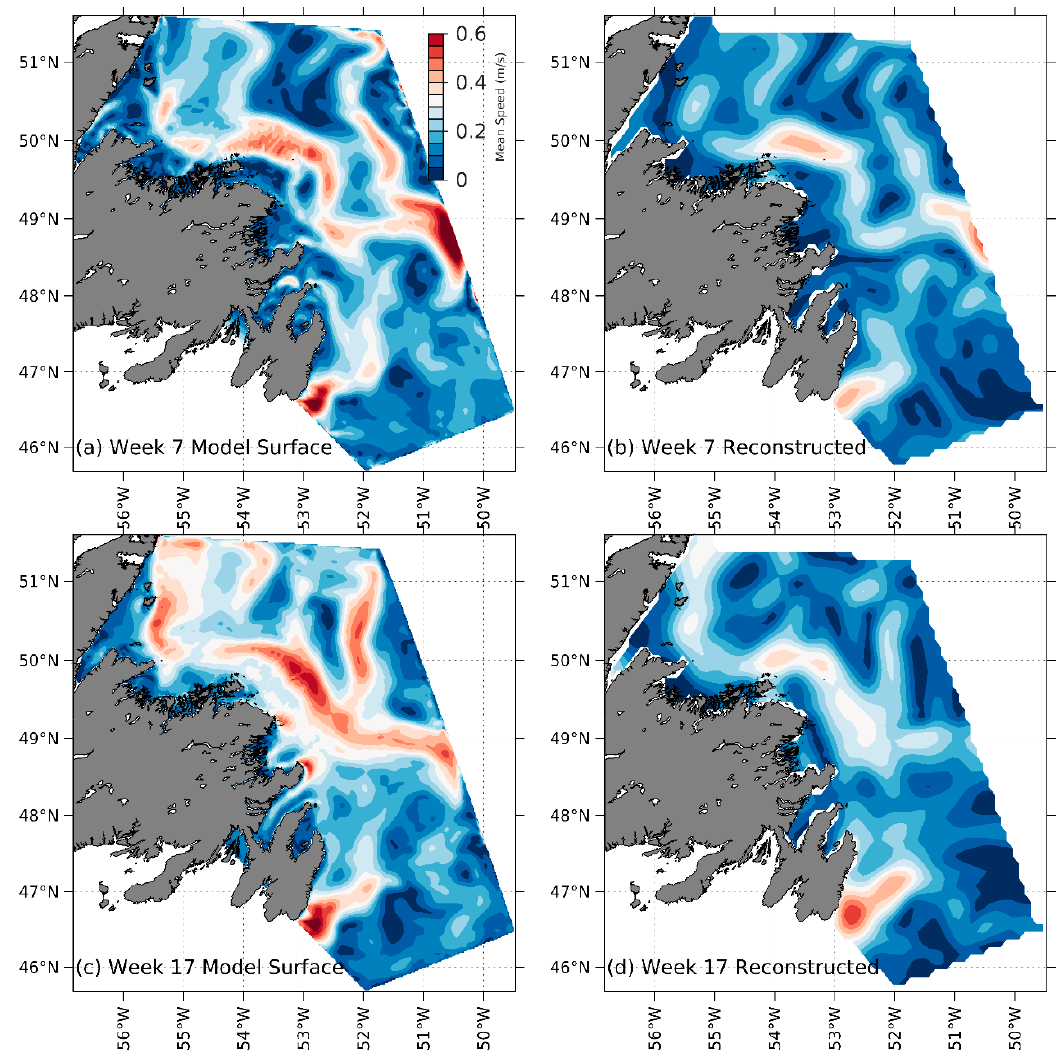
Figure 6. Mean model surface current for ( a ) the 7th week and ( c ) the 17th week. ( b ) and ( d ) as in ( a ) and ( c ), but for mean reconstructed surface current derived from the mapped SSH.